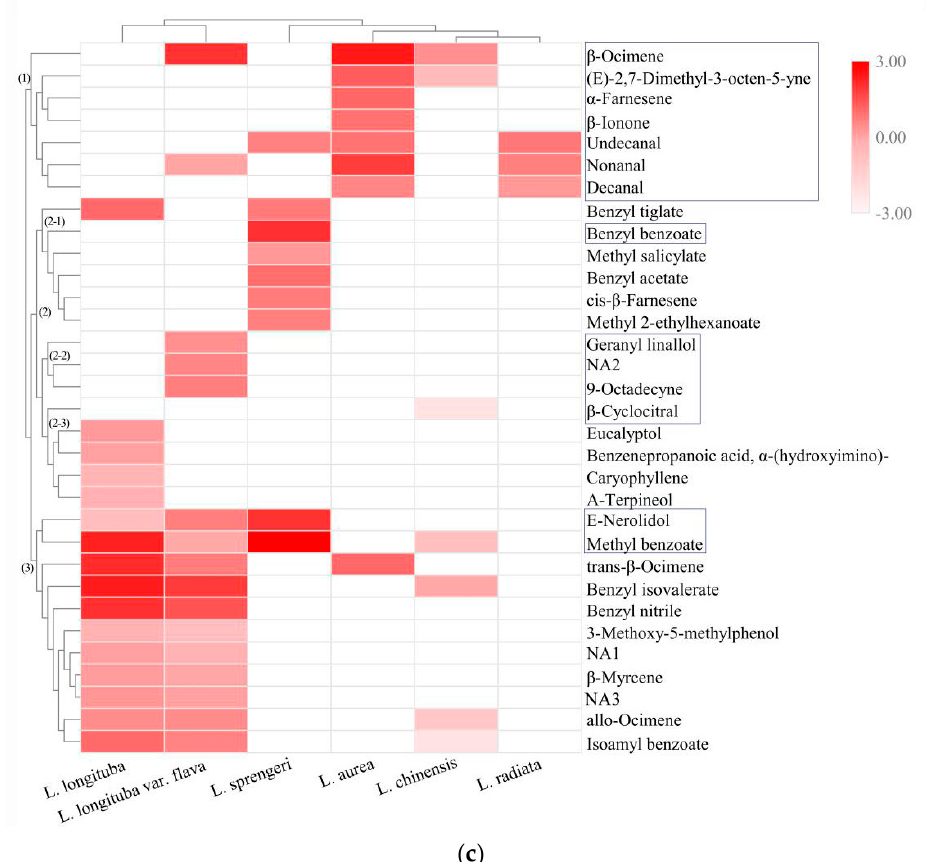
Figure 3. Chemometric analysis of volatile organic compounds (VOCs) in six Lycoris taxa detected by GC-MS. ( a ) Score plot and ( b ) loading plot of tepal GC-MS profiles of six Lycoris taxa using a partial least squares-discriminant analysis (PLS-DA). ( c ) Clustering of the 32 VOCs detected in six Lycoris taxa. VOCs coded in the loading plot were: (1) NA3; (2) β -myrcene; (3) eucalyptol; (4) trans - β -ocimene; (5) methyl 2-ethylhexanoate; (6) β -ocimene; (7) methyl benzoate; (8) nonanal; (9) allo-ocimene; (10) (E)-2,7-dimethyl-3-octen-5-yne; (11) benzyl nitrile; (12) benzyl acetate; (13) Α -terpineol; (14) methyl salicylate; (15) decanal; (16) β -cyclocitral; (17) 3-methoxy-5-methylphenol; (18) NA1; (19) benzenepropanoic acid, α -(hydroxyimino)-; (20) undecanal; (21) benzyl isovalerate; (22) caryophyllene; (23) isoamyl benzoate; (24) trans - β -farnesene; (25) β -ionone; (26) benzyl tiglate; (27) α -farnesene; (28) E-nerolidol; (29) NA2; (30) 9-octadecyne; (31) benzyl benzoate; and (32) geranyl linallol. The compounds in black frames are the 14 key VOCs. White indicates low expression and red indicates high expression.